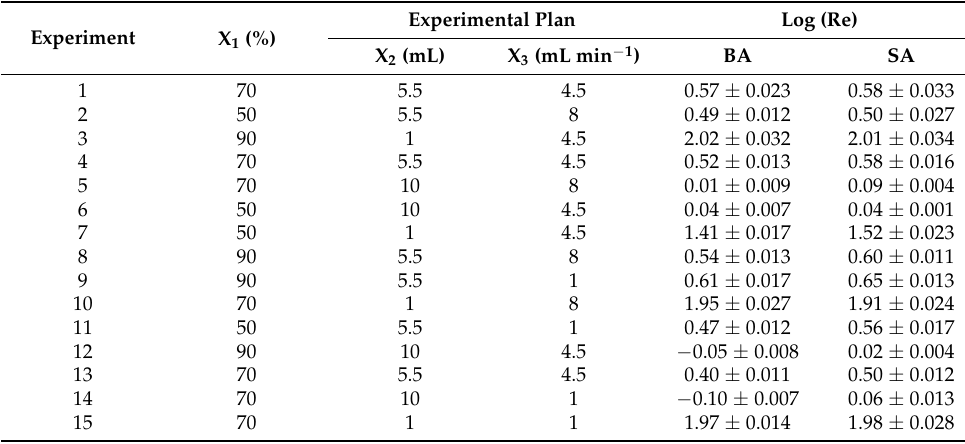
Figure 5. Response surface plots showing the effect of the sample pH and flow rate on percolation efficiency: sample volume = 1 mL. ( a ) 𝑹 𝒓𝑩𝑨 ; ( b ) 𝑹 𝒓𝑺𝑨 . Table 5. Experimental plan and results of the BBD for the elution